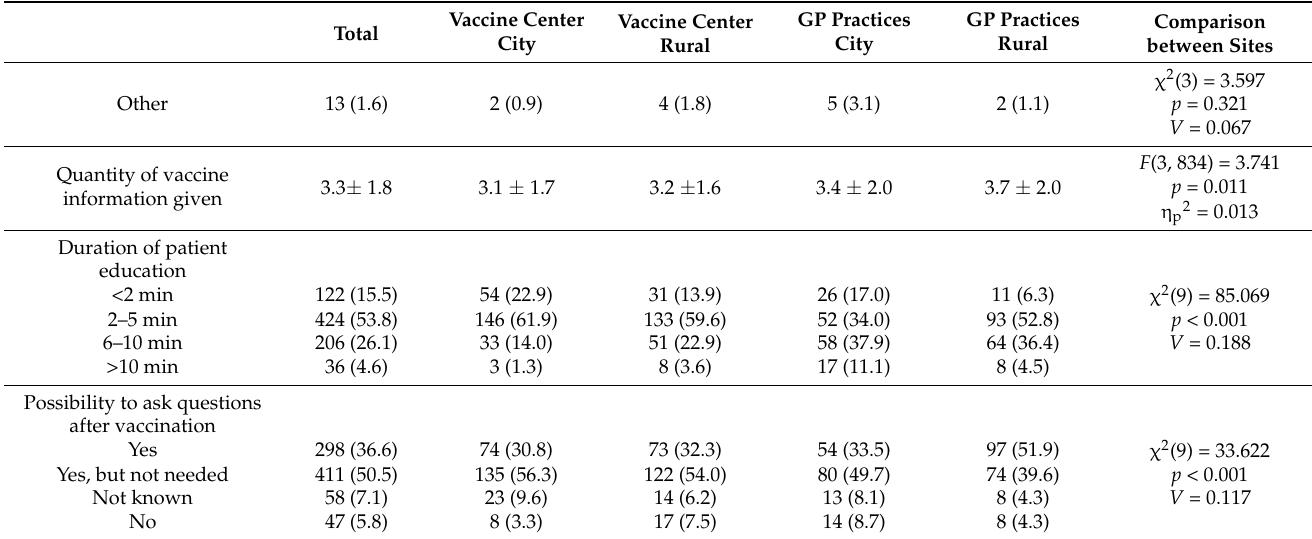
Figure 5. Differences between sites in participants’ overall satisfaction with the patient education ranging from 1 = Not at all satisfied to 10 = Very satisfied. The ANOVA revealed that participants in rural GP practices and in the rural vaccine center felt more satisfied with the patient education compared to participants in city GP practices and in the city vaccine center ( F (3, 816) = 8.609, p < 0.001, η p2 = 0.031). In general, satisfaction was high in all sites.